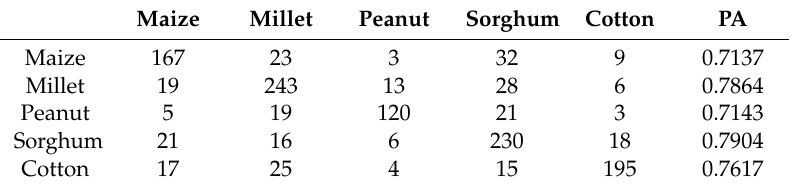
Table 7. Confusion matrix applying an ensemble of 75 classifiers. PA: Producer accuracy per class. Maize Millet